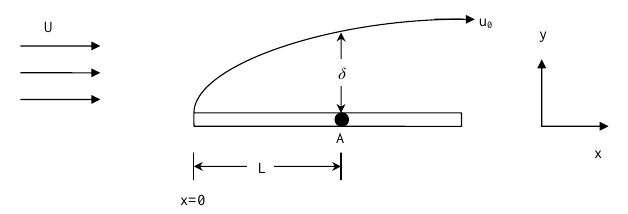
Fig 2. Laminar boundary layer growth over a flat surface where the boundary layer depth is of the Fig. 2. Laminar boundary layer growth over a flat surface where the Fig 1. Laminar boundary layer growth over a wedge of angle 2 θ boundary layer depth is of the order of δ and the velocity of flow in order of δ and the velocity of flow in the x-direction at the boundary layer is u 0 . the x-direction at the boundary layer is u 0